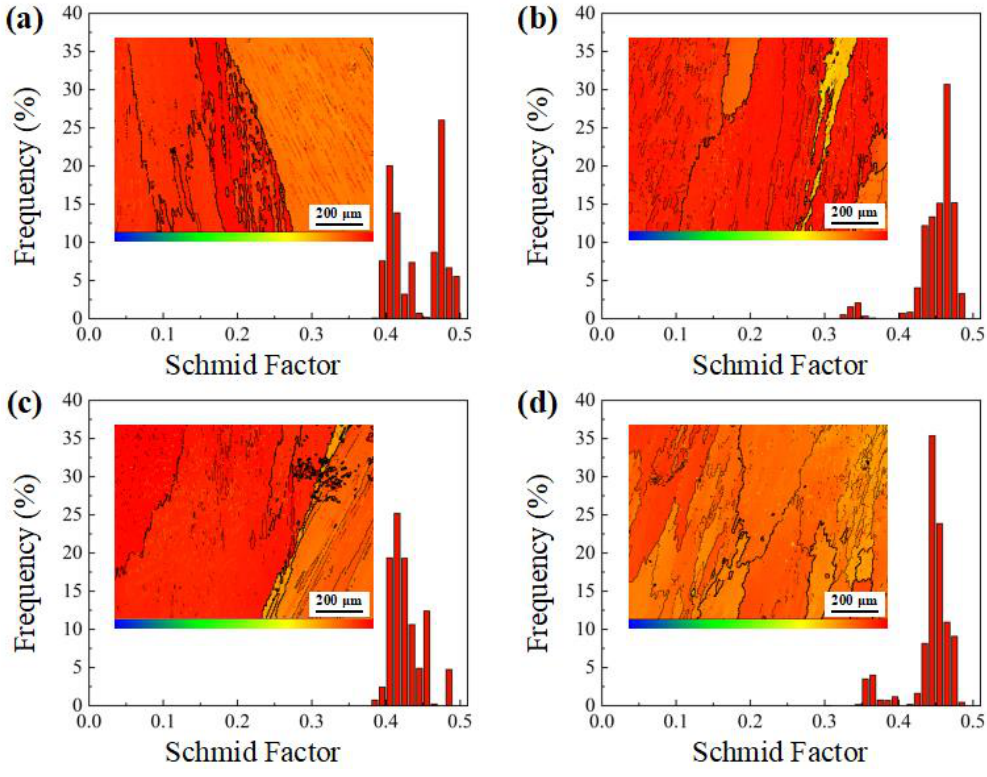
Figure 17. SF of the LMD-Al 0.5 FeCoCrNi walls under different heat dissipation rates: ( a ) T-0; ( b ) T- 20; ( c ) T-40; ( d ) T-60. ( c ) T-40; ( d )